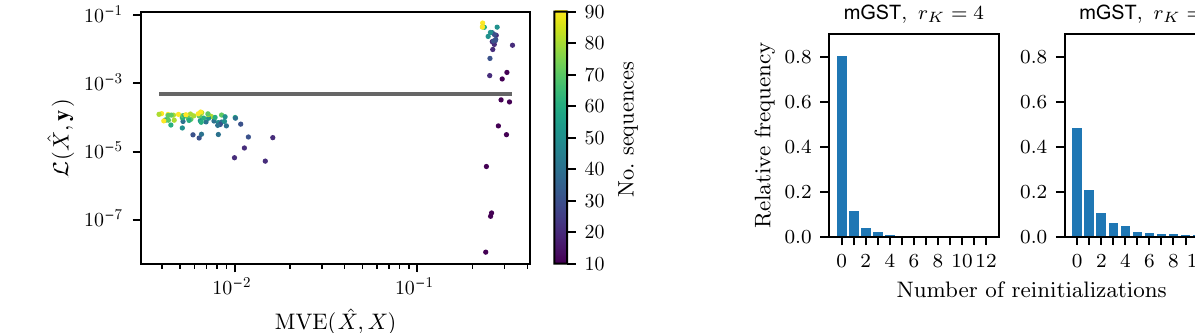
FIG. 6. Relative frequencies of reinitialization counts for mGST run on modified XYI models (see the main text for